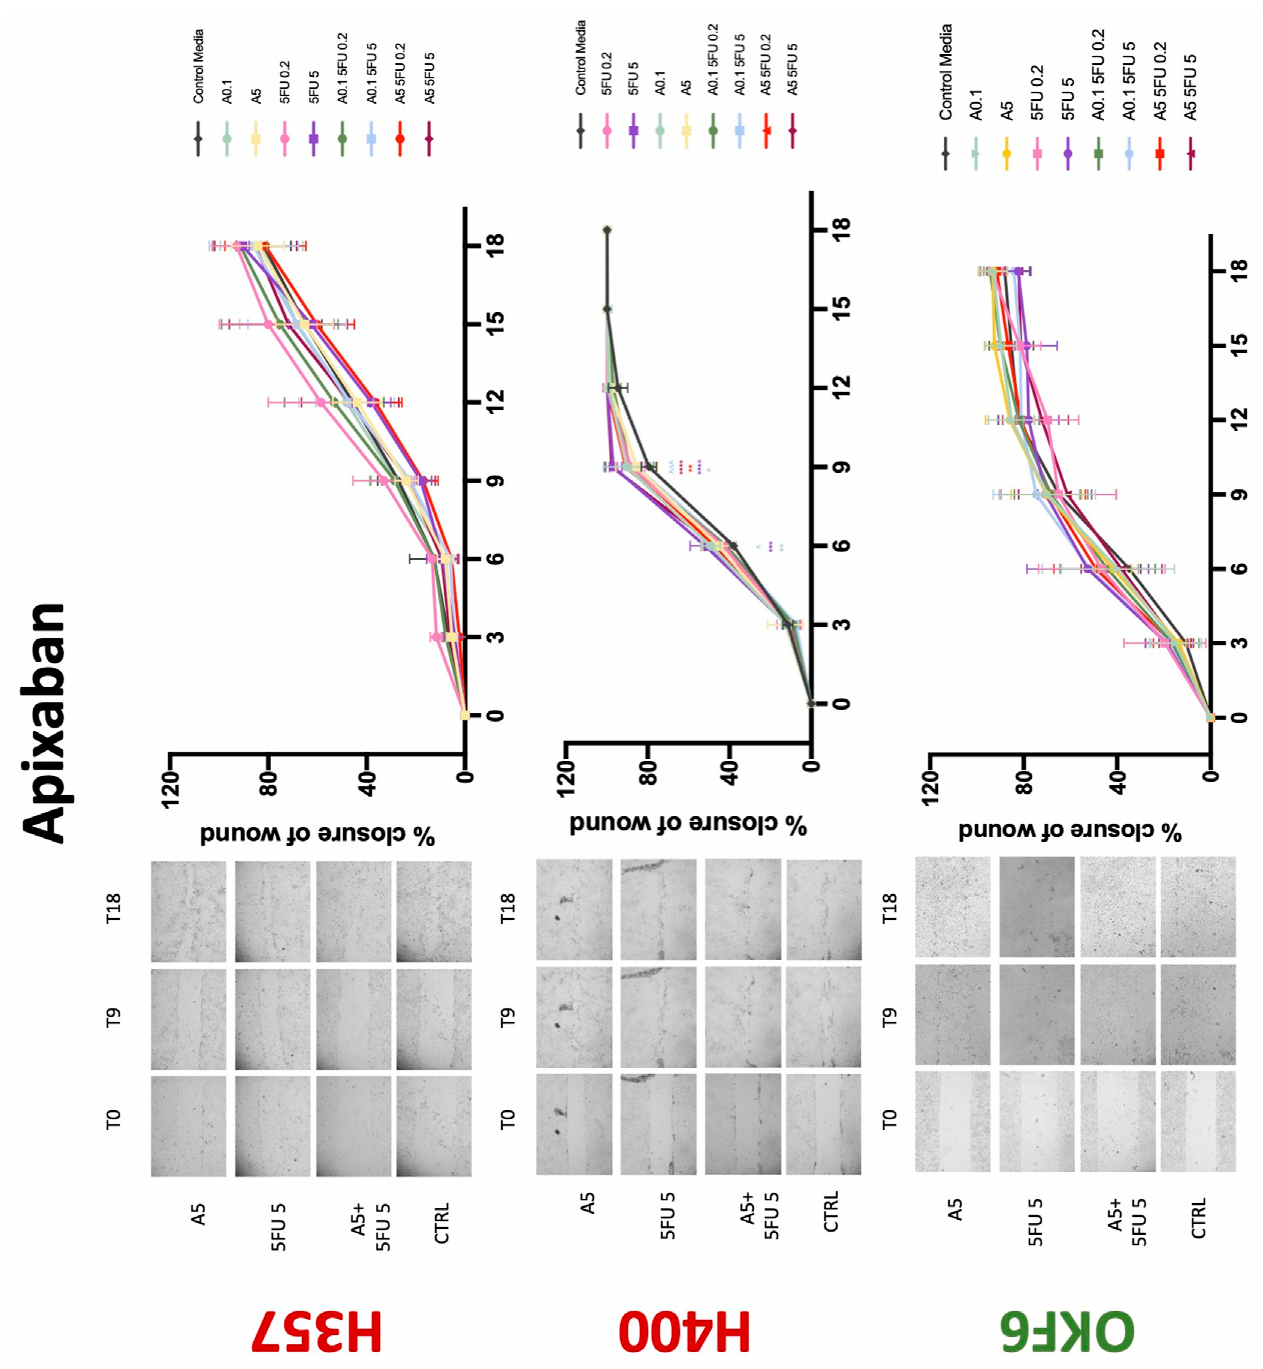
Figure 10. Wound healing assay . The effect of (0.1/5 µ g/mL) apixaban and (0.2/5 µ g/mL) 5-FU on H357, H400, and OKF6 cell migration. Data are represented as mean ± SD. Statistical significance is given as follows: * p < 0.05, ** p < 0.01, *** p < 0.005, **** p < 0.001; (*) compared to control group; ˆˆˆ p < 0.005; (ˆ) compared to respective 5-FU groups.